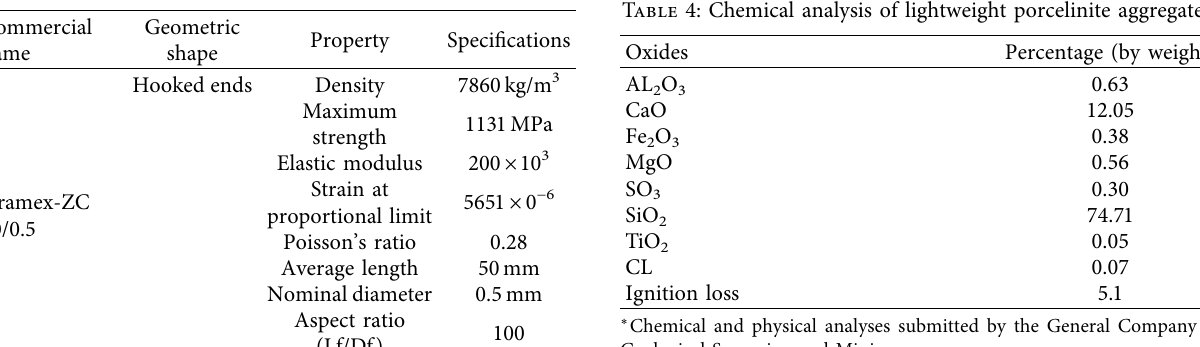
Table 2: Properties of steel fibers ∗ .